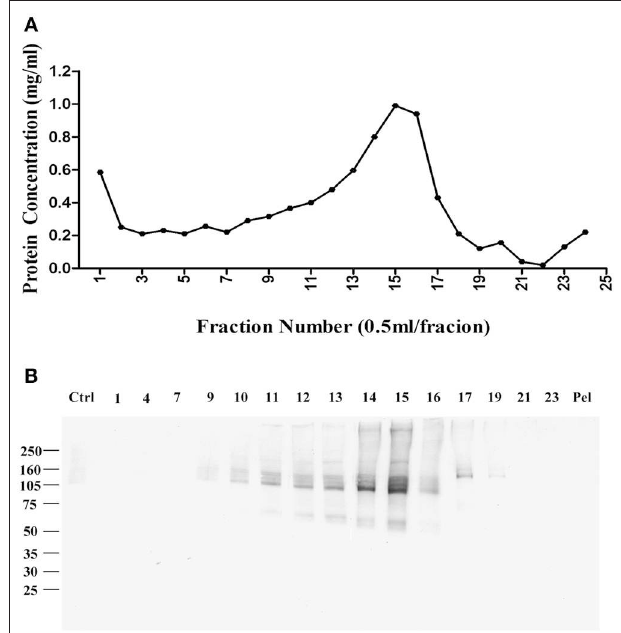
FIGURE 1 | Enrichment of A β O binding protein p100 by linear sucrose gradient ultracentrifuge. Cortical membrane was resuspended in Tris-HCl buffer with cholate, which was separated by linear sucrose gradient ultracentrifugation. The fractions from the top to the bottom were collected at 1ml per fraction, and the pellets were solubilized in 1ml 1% SDS. (A) The protein concentration in each fraction. (B) A β O binding proteins in each fraction identified by ligand blotting. Endogenous A β O binding p100 as found primarily in fractions 14 and 15 Pel: